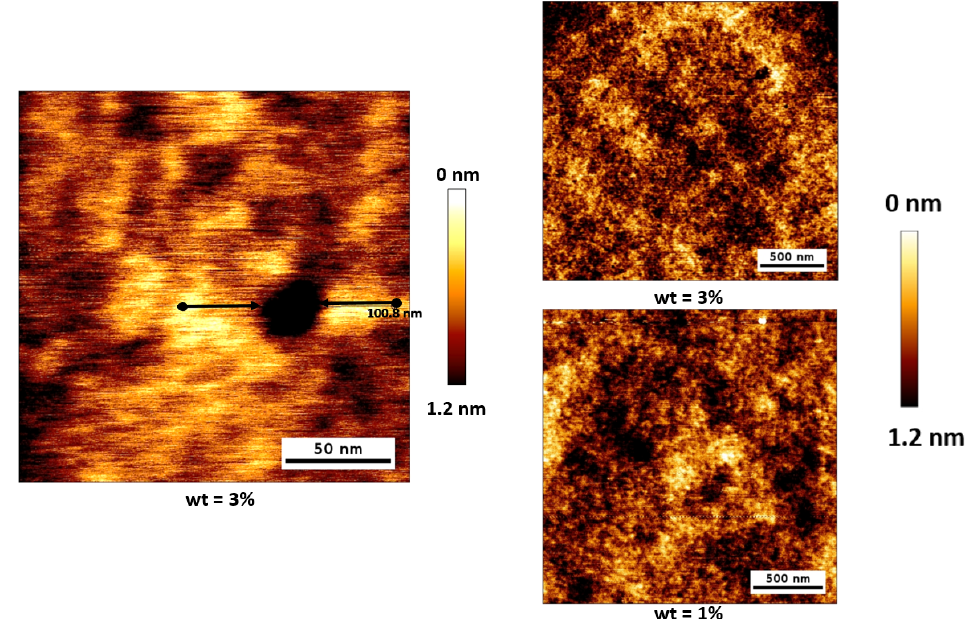
Figure 4. AFM picture of PSAN thin film surface with wt = 3% and wt = 1%.